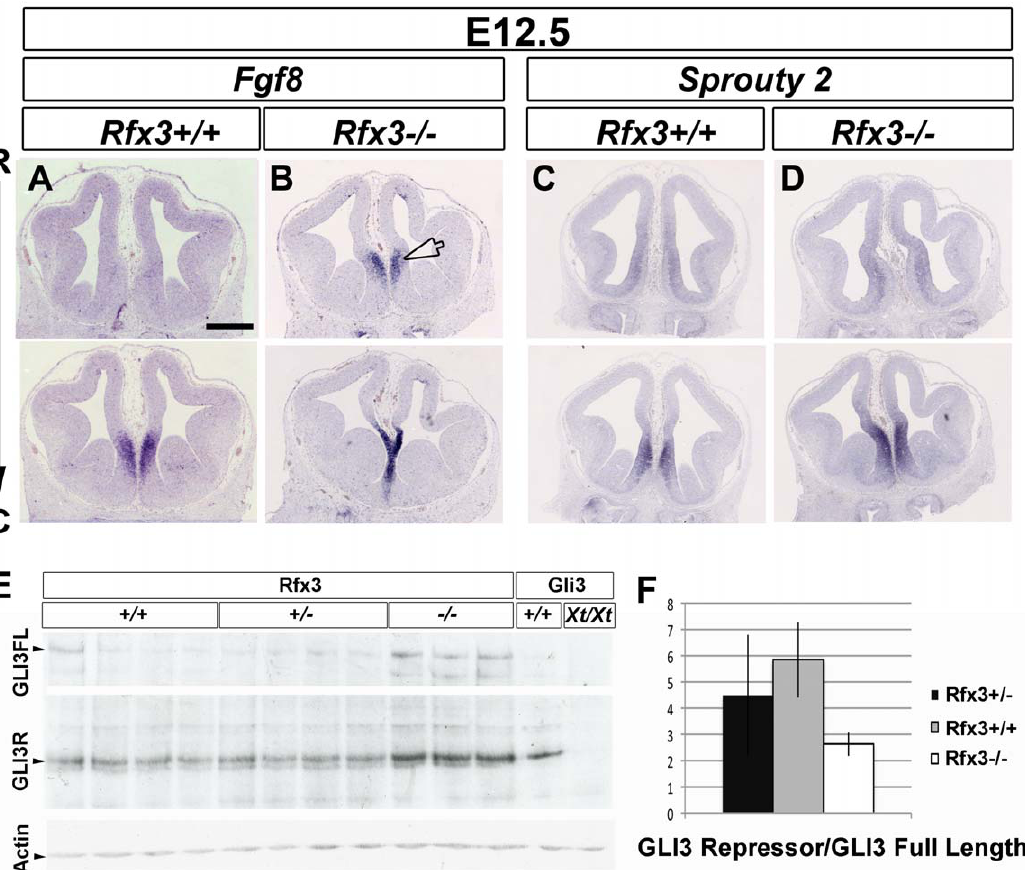
Figure 7. Disturbed expression of Fgf8 and of the ratio of GLI3 repressor/GLI3 activator forms in Rfx3 2 / 2 CSB. In situ hybridization for Fgf8 (A and B), Sprouty2 (C and D) mRNAs on coronal sections from E12.5 WT (A and C) and Rfx3 2 / 2 (B and D) mice at the CSB. Fgf8 expression domains is expanded into the rostromedial pallium in Rfx3 2 / 2 embryos. Interestingly, the frontier region between the septum and the cortex is reduced in the mutant compare to WT (arrowhead). In addition, Sprouty2 expression is slightly increased in the Rfx3 mutant. Bar=500 m m in all figures. (E) Western blot analysis of E13.5 individual forebrains from Rfx3 + / + , Rfx3 + / 2 and Rfx3 2 / 2 embryos from a same litter. As control, extracts from bodies of Gli3 + / + or Gli3 Xt/Xt embryos were included. No GLI3 protein is produced in Gli3 Xt mutants allowing the identification of GLI3 specific bands. (F) Quantification of the Western blot shows that the ratio of GLI3 repressor form to the full-length form is reduced in Rfx3 deficient mice compared to heterozygotes and WT